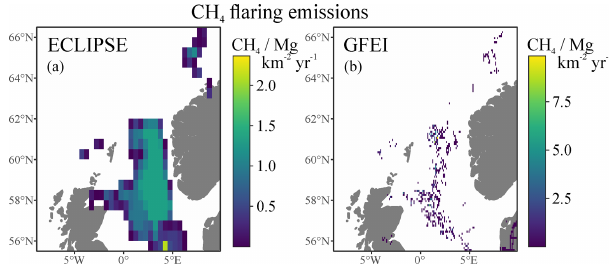
Figure D1. (a) ECLIPSE v5 CH 4 flaring emissions over the North Sea, at 0 . 5 ◦ × 0 . 5 ◦ for 2020 (Stohl et al., 2015). (b) GFEI CH 4 flar- ing emissions over the North Sea, at 0 . 1 ◦ × 0 . 1 ◦ for 2019 (Scarpelli et al., 2020).